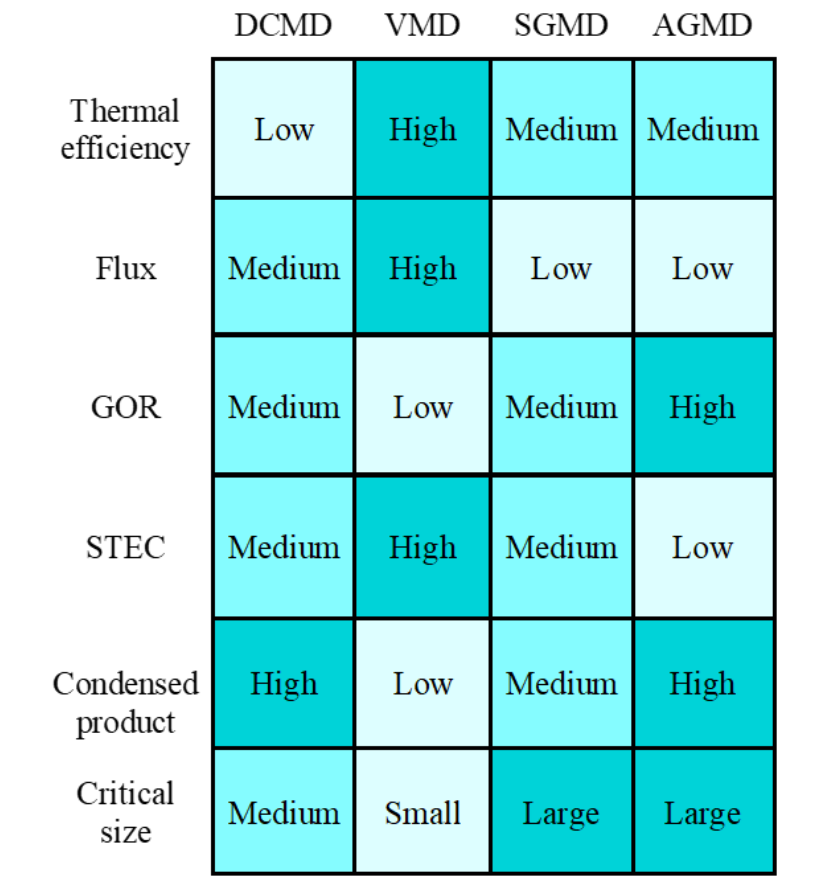
Figure 15. Qualitative summary of various MD configurations versus various key efficiency, operat- ing, and economic parameters.